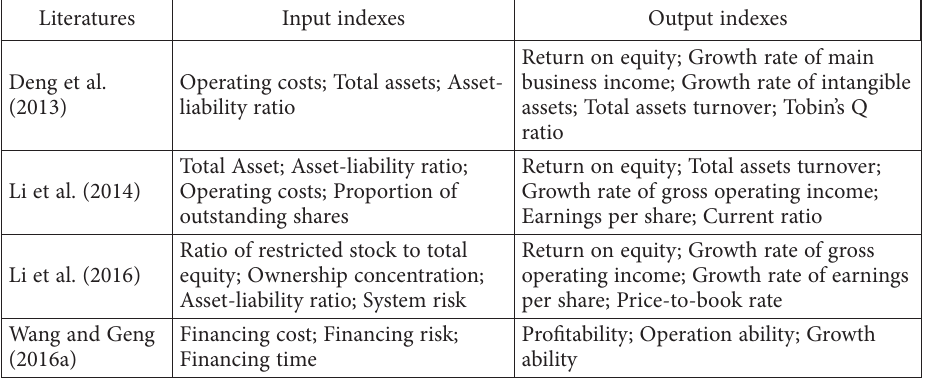
Table 3. Input and output indexes adopted by some scholars based on DEA